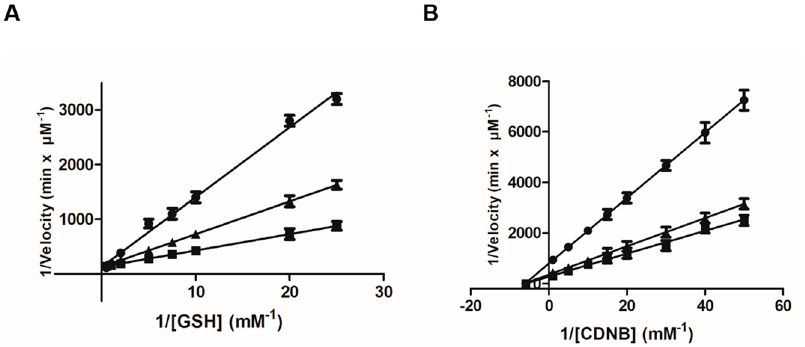
Figure 3. Lineweaver–Burk plots for the inhibition of hGSTA1-1 by fisetin. ( A ) Inhibition of hGSTA1-1 by fisetin [(0 μ M ( ■ ), 0.5 μ M ( ▲ ), 2.5 μ M ( ● )] using the concentration of the CDNB con- stant, and the concentration of GSH was varied (0.04–2.0 mM). ( Β ) Inhibition of hGSTA1-1 by fisetin [(0 μ M ( ■ ), 1 μ M ( ▲ ), 3.5 μ M ( ● )] using the concentration of GSH constant, and the concen- tration of CDNB was varied (0.0375–0.675 mM).